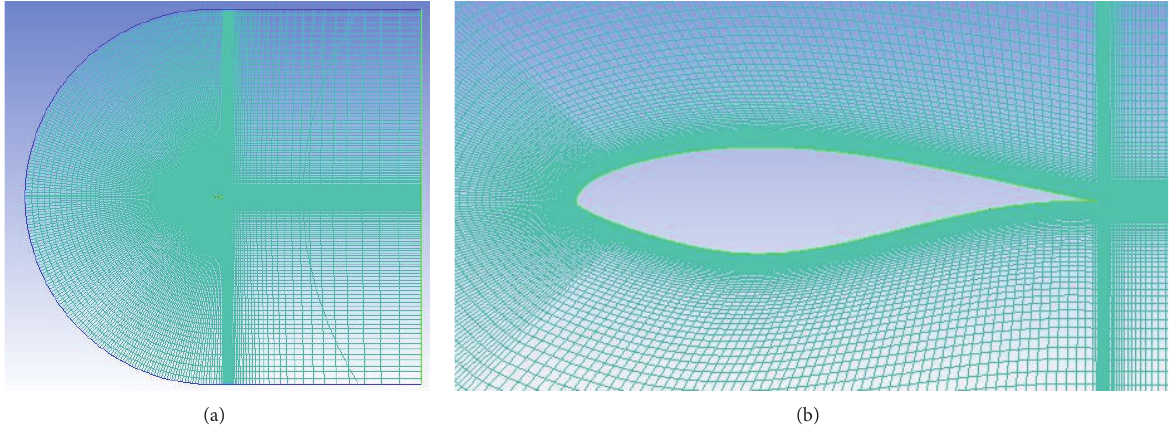
Figure 3: Structured C-grid around NREL S809 airfoil: (a) entire mesh in the computational domain and (b) zoomed-in view of the mesh near the airfoil.